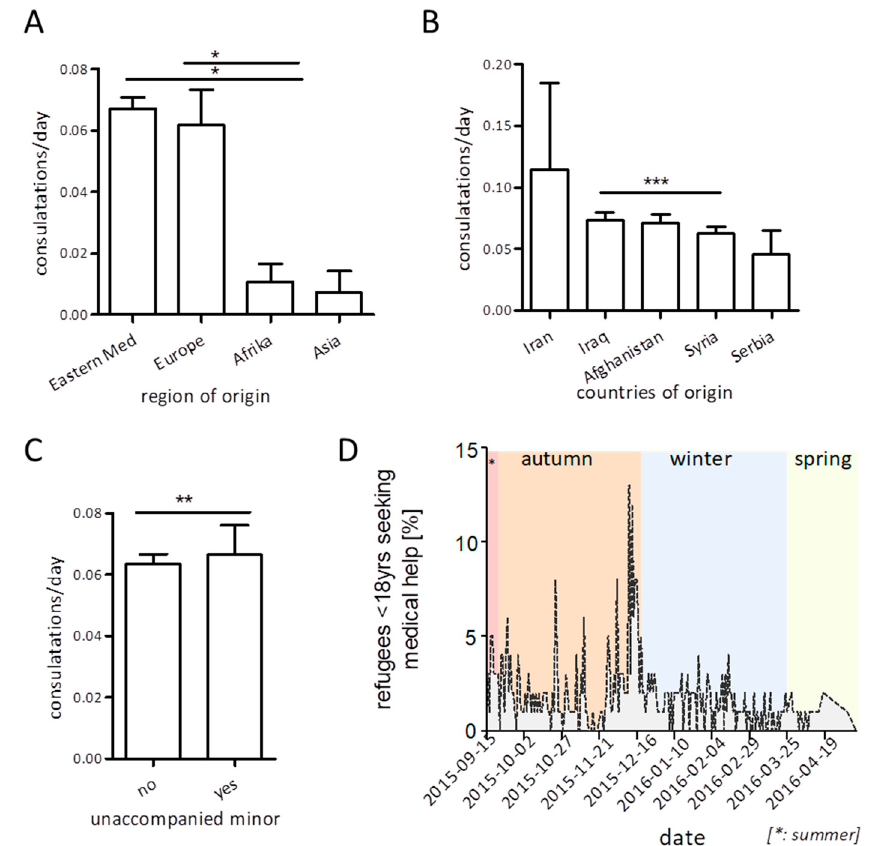
Figure 3. Visit frequencies normalized to day of stay at the refugee residence depending on regions ( A ) or country ( B ) of origin. Influence of family-accompany status ( C ) and seasonal changes ( D ) on healthcare utilization within the cohort (bars display mean + SEM ( A , B , D ), linear regression in ( C ), * p ≤ 0.05, ** p ≤ 0.01 *** p ≤ 0.005).